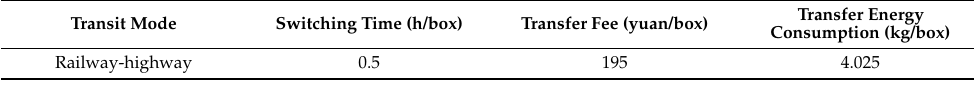
Table 3. Switching time, cost, and energy consumption.